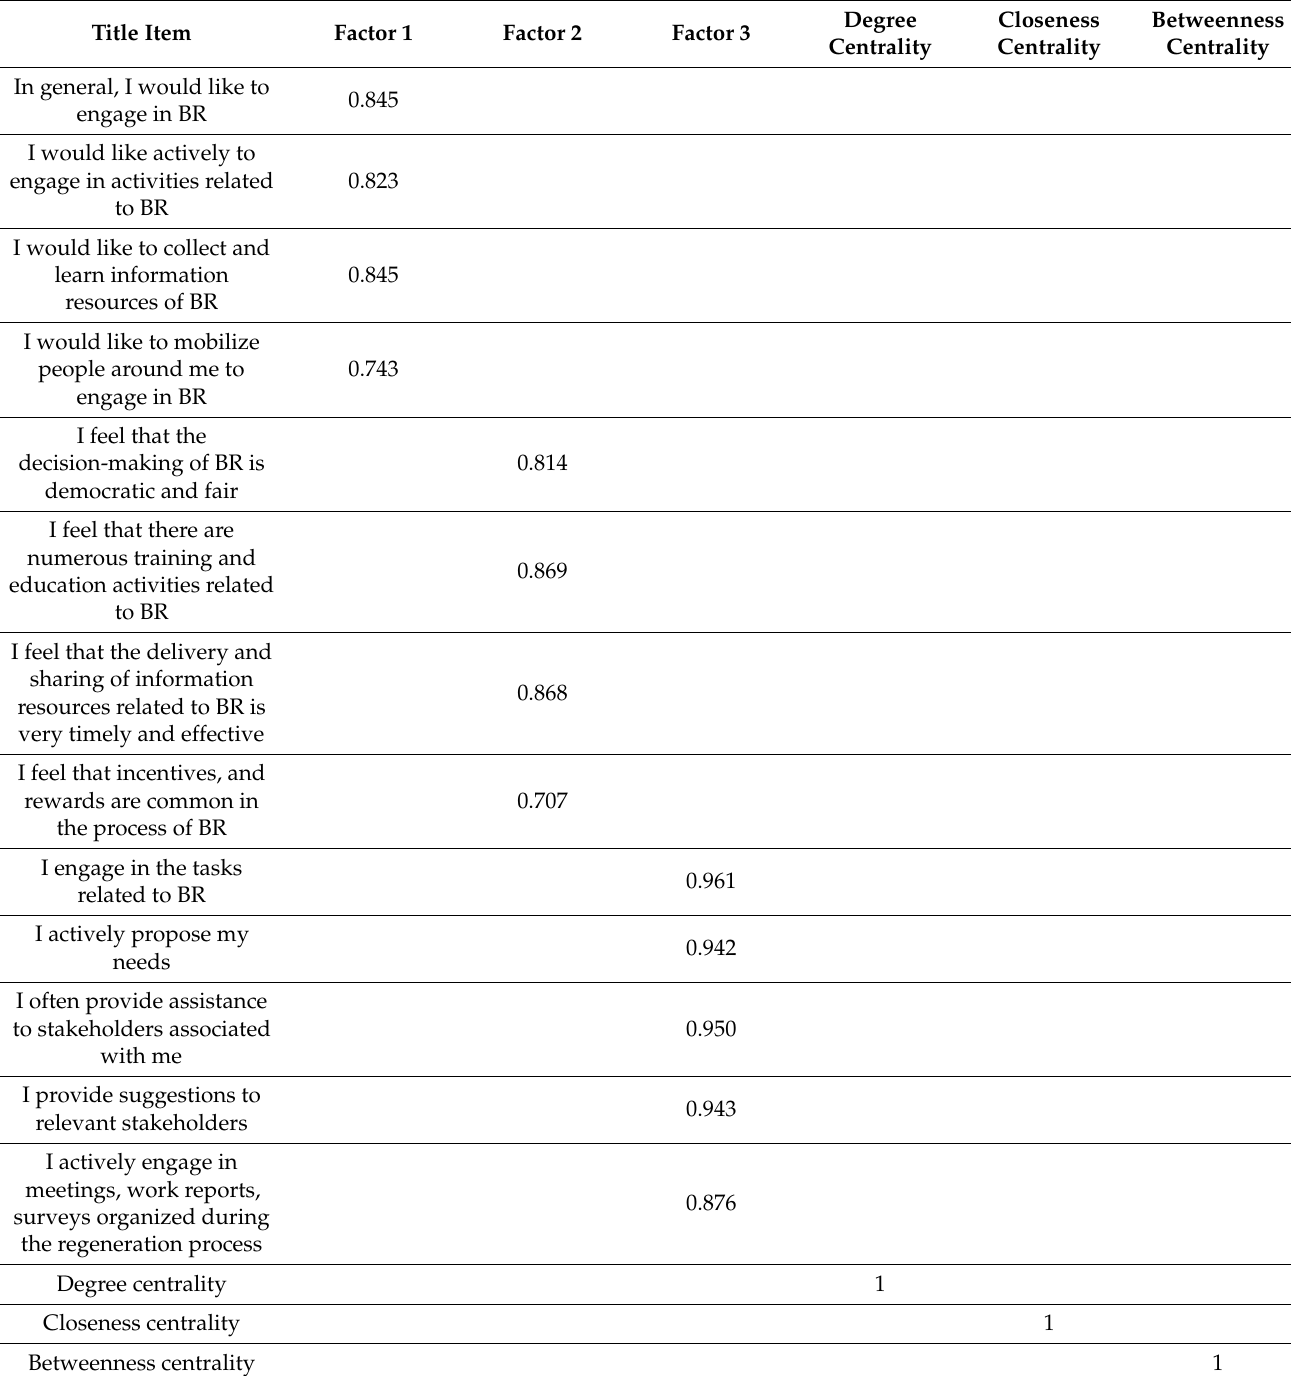
Table 4. Results for the factor loadings corresponding to each question